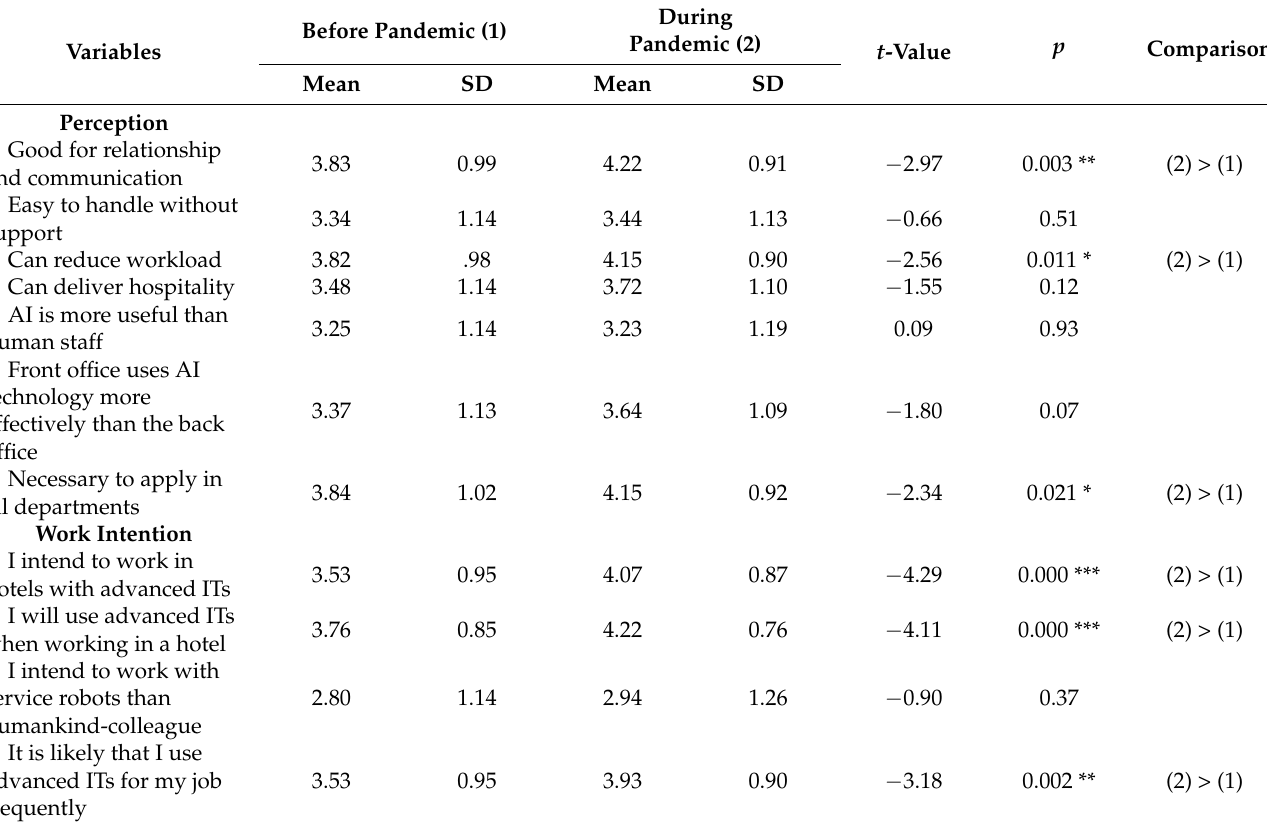
Table 4. Mean comparisons on perceptions of ITs and work intention during COVID-19